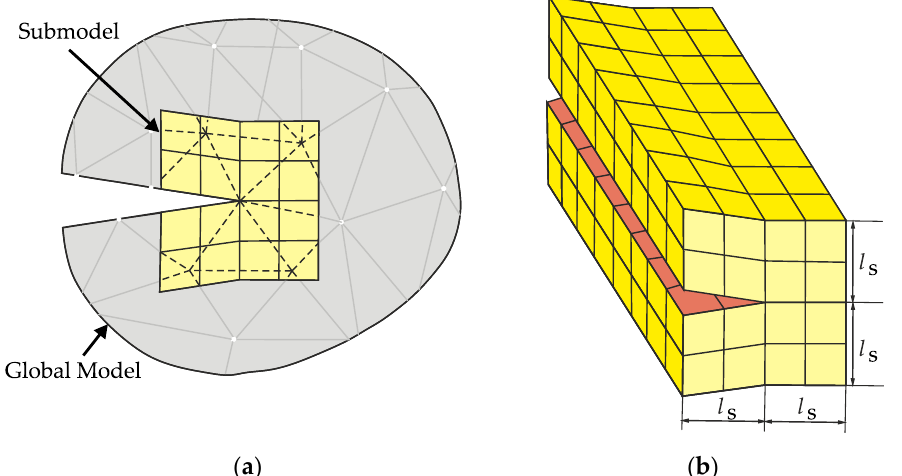
Figure 6. Aspects of a submodel from Adapcrack3D: ( a ) The position of the submodel with respect to the global model; ( b ) The geometry of the submodel with hexahedral mesh with the size of the submodel.